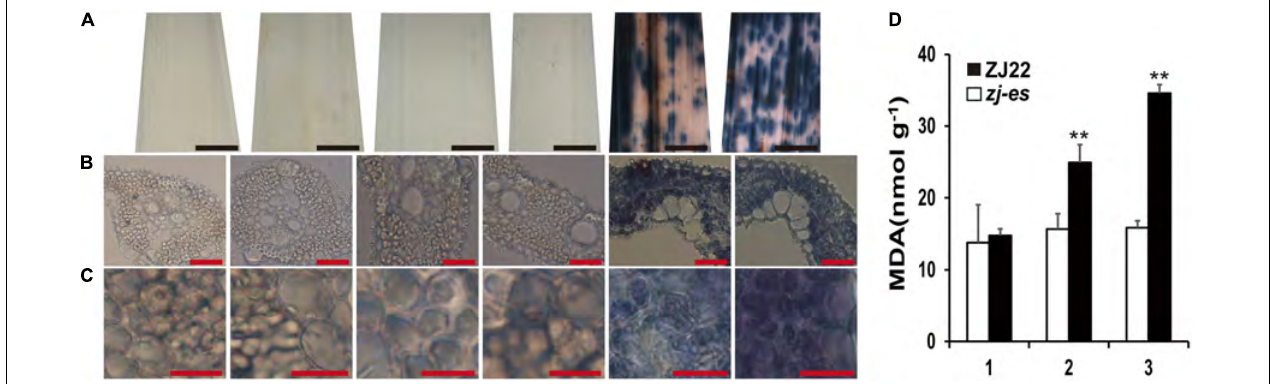
FIGURE 12 | Trypan blue (TB) staining and the determination on the leaves of ZJ22 and zj-es sampled at the six-leaf stage. Each set of images represents (from left to right) the flag, second and third leaves of ZJ22, and then the flag, second and third leaves of zj-es . (A) Leaf phenotype; red scale bar = 0.2 cm. (B) Cell